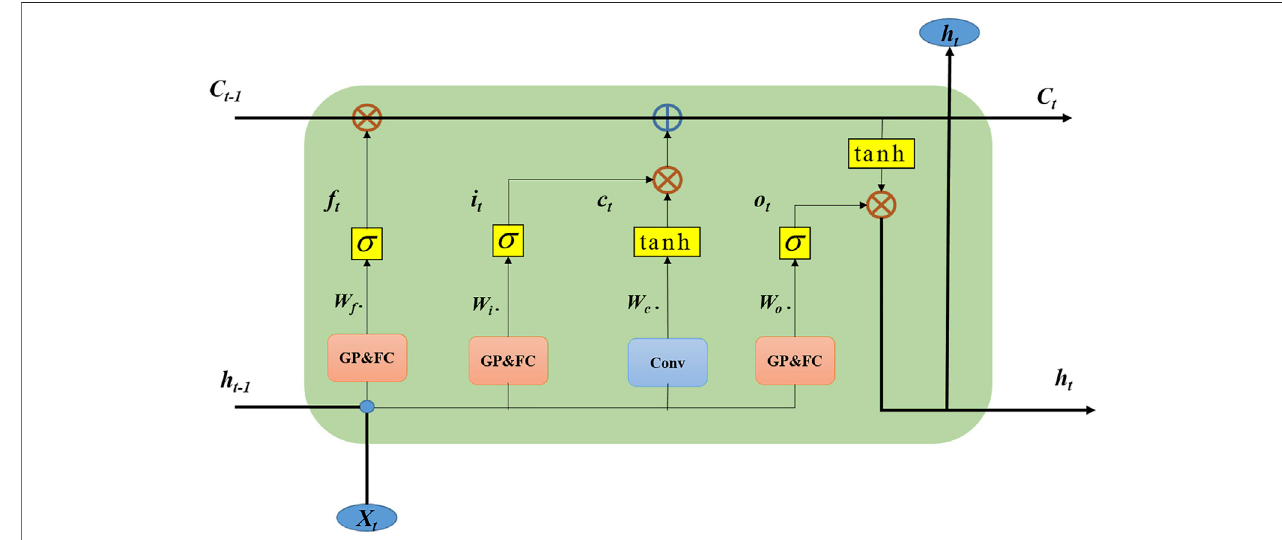
FIGURE 5 | The structure of Variant